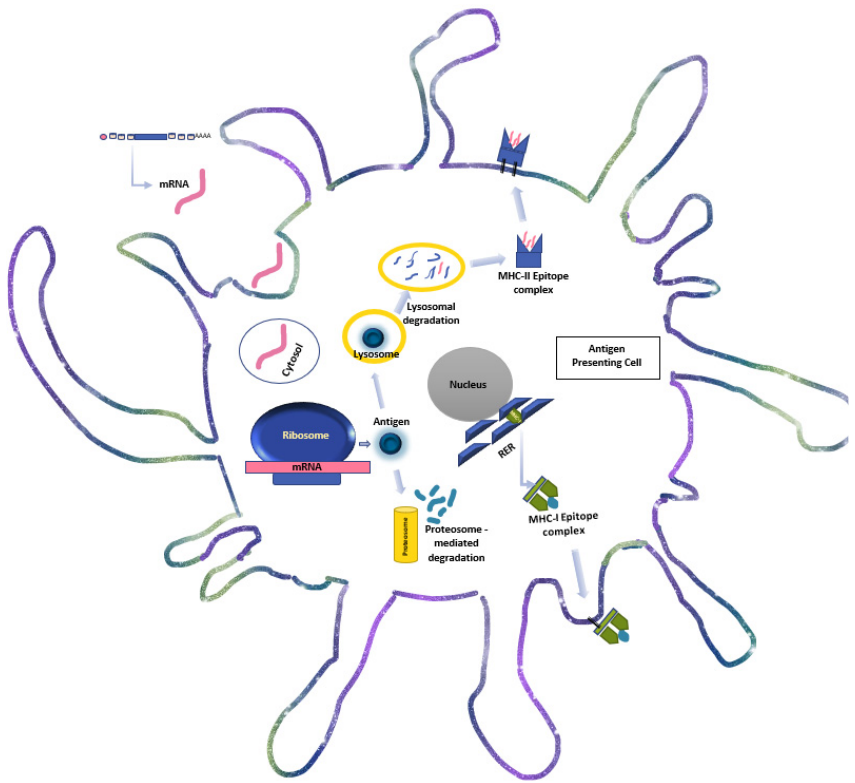
Figure 1. Schematic diagram of intracellular events in mRNA processing by the antigen presenting cells. mRNA enters the cell through the cytosol and translated by the ribosome into the encoded antigen. The antigen is then: (A) degraded into small protein fragments and epitope by the proteo- some, which combine with the MHC-I complex at the rough endoplasmic reticulum and traffics to the cell membrane for presentation to naive CD8 (+) cytotoxic T cells; (B) either exocytosed to re- enter the APC through endocytosis or enters the autophagic pathway. Then, the antigen is split into fragments and its epitopes by lysosomal degradation. These epitopes bind with the MHC-II com- plex and are transferred to the cell membrane to activate naive CD4 (+) T lymphocytes. (MHC: major histocompatibility complex, RER: rough endoplasmic reticulum). 4. The Immunogenicity and Molecular Biology of mRNA-Based Immunotherapy Therapeutic mRNAs are produced through in vitro transcription (IVT) catalyzed by DNA-dependent RNA polymerase, which selectively recognize the promoter region of DNA templates [32]. The end product is a naked mRNA strand, which should be modified to optimize the stability and translational ability. These modifications include capping the 5 ′ end, optimizing the sequence of the untranslated translating regions, and adding a poly- A tail [33]. Nevertheless, these alterations and byproducts generated during the IVT pro- cess may impede the desired antitumor response through activation of the innate immune system, leading to the recognition of the modified mRNA molecules as nonself, as well as interference with the transcriptional capacity by cellular stress mechanisms [34]. As the first line of defense against external and internal pathogens, the innate im- mune system initiates a cascade of events subsequently triggering adaptive cancer-spe- cific immunity. Endogenous and exogenous non-self-nucleic acids are recognized by in- tracellular pattern recognition receptor family (PRR) comprising TLRs, RIG-I-like recep- tors, nucleotide-binding and oligomerization domain (NOD)-like receptors, C-typelectin receptors, absent-in-melanoma 2 (AIM2)-like receptors, and the cyclic GMP-AMP syn- thase. Activation of PRRs localized in the cytosol and endosomal compartment in turn lead to transcriptional activity of several proinflammatory cytokines and chemokines, and stimulation of transcription-independent intracellular pathways such as autophagy, apoptosis, and phagocytosis. Studies with synthetic nucleic acids to manipulate the